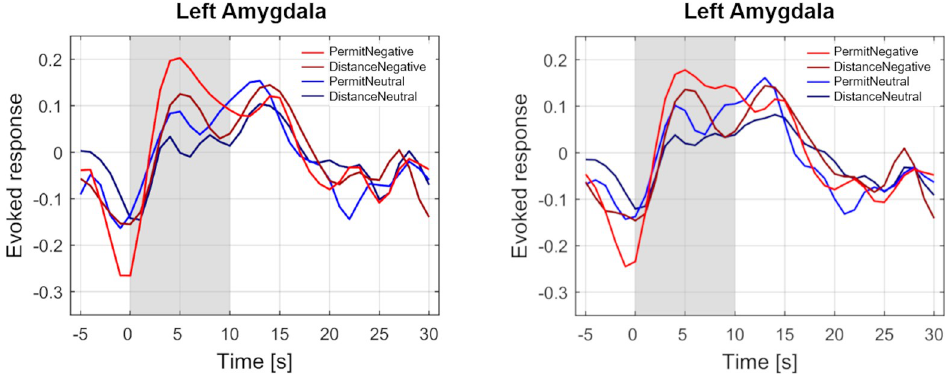
Fig 4. Activation time-courses in the left and right amygdala during stimulation (timepoint 1) and post- stimulation phase (immediate aftereffects, timepoint 2). The shaded area indicates the stimulation